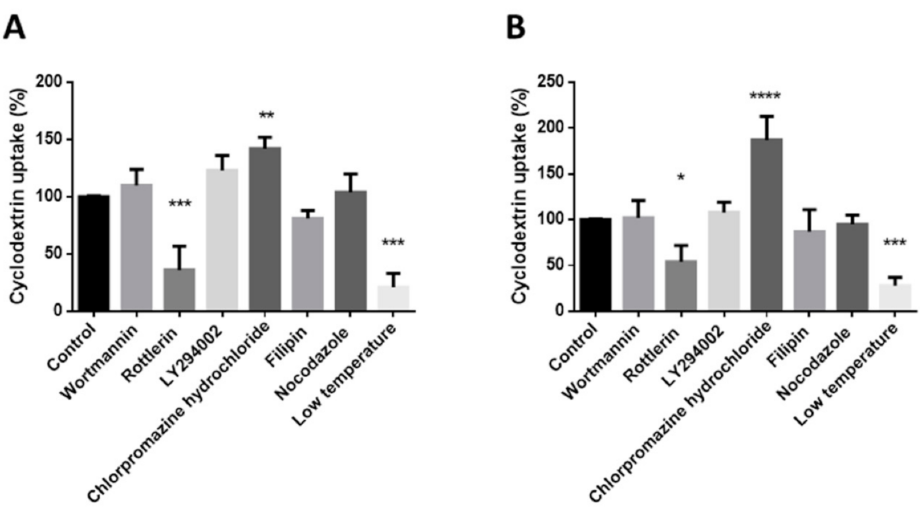
Figure 4. Effects of different inhibitors and cooling on the cellular uptake of FITC-HPBCD ( A ) and FITC-RAMEB ( B ) compared to the untreated control. Cooling almost perfectly inhibited the endocytosis, while rottlerin, the macropinocytosis inhibitor, significantly inhibited the endocytosis. Wortmannin and LY294002, another macropinocytosis inhibitor and filipin, which is the inhibitor of the caveola-mediated endocytosis, had no significant inhibitory effects on endocytosis. Mean ± SD are depicted ( n = 3). * p < 0.05, ** p < 0.01, *** p < 0.001, **** p < 0.0001 vs. control based on ANOVA.